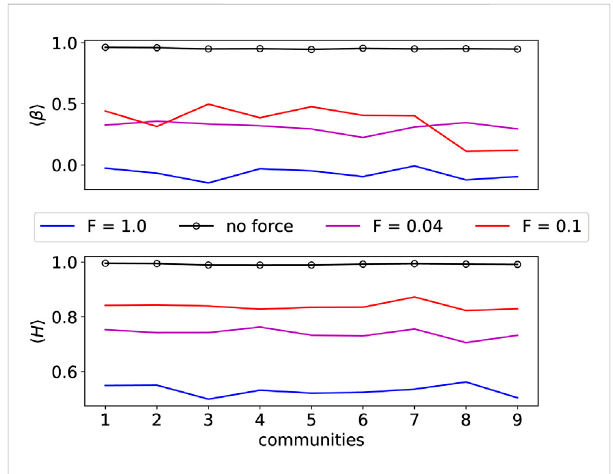
FIGURE 8 Hurst and β exponents of all fruit- fl y connectome communities. In the forceless case at the critical Hopf transition coupling, the H exponent is the largest for every community. With forces these values drop for each community. This shows a resemblance with the restandnon-reststudiesofdifferentbrainareasin[63],showing 〈 H 〉 ≈ 1.0 at resting state and 〈 H 〉 ≈ 0.7 at task driven